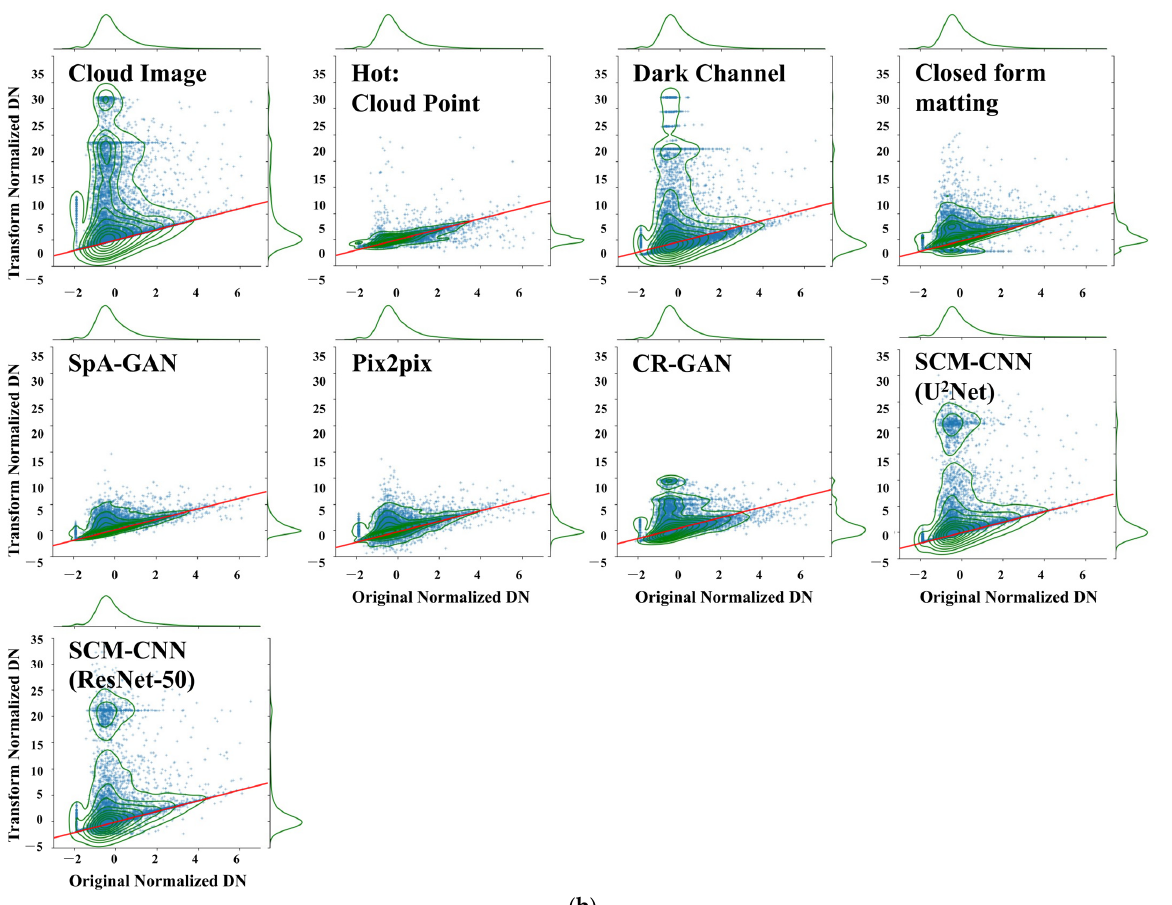
Figure 6. ( a ) Comparison of several cloud opacity estimating techniques. SCM-CNN and Closed- form matting generate the cloud opacity layer directly, whereas Dark Channel is based on the transmissivity layer back-calculated to obtain the cloud opacity layer. The remaining methods are based on cloud removal results using the actual CMaxDN values directly back-calculated to obtain. ( b ) Results of cloud opacity estimation against real values for various cloud removal techniques. One hundred thousand points are selected at random from the results of the opacity estimation, and their distributions are calculated. The Figure’s red line represents the ideal estimate; the closer the data distribution is to the line the more trustworthy the cloud removal results. The green curve depicts the probability density of the dispersed dots.